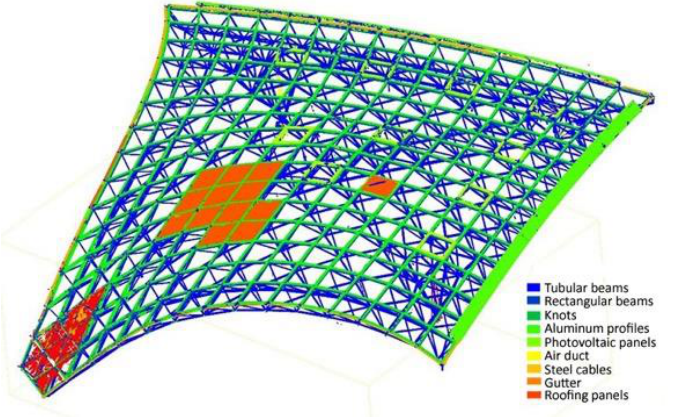
Figure 16. Classified point cloud, first level of classification.